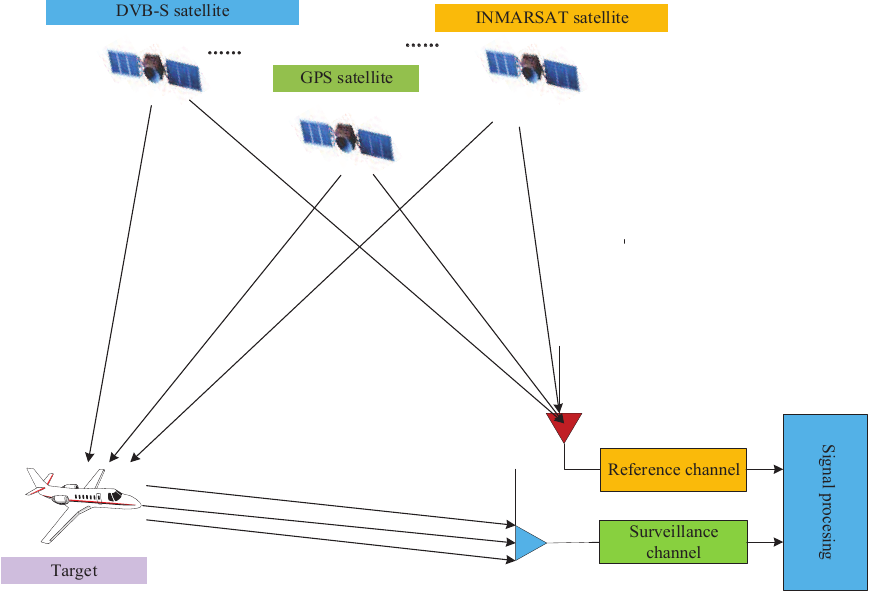
Figure 1. Passive detection system model based on multiple collaborative heterogeneous